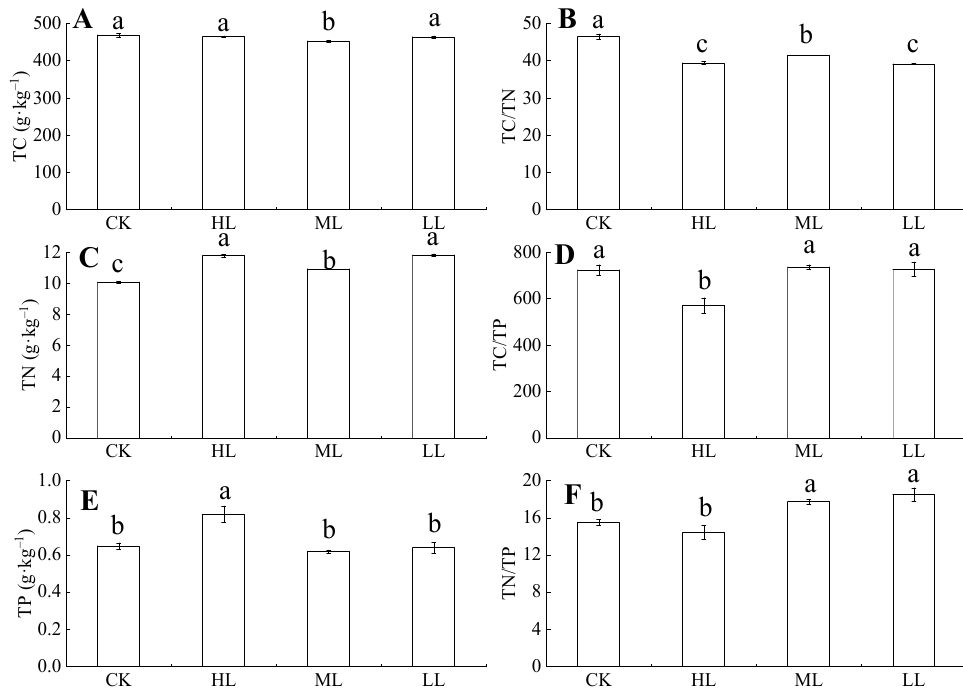
Figure 5. The TC, TN, TP contents and their ratios in C. oleifera leaves under different light regimes. Note: Parameters include TC ( A ), TC: TN ( B ), TN content ( C ), TC: TP ( D ), TP ( E ), and TC: TP ( F ) of C. oleifera under different light regimes. Different lowercase (a, b, c) letters represent significant differences between light regimes ( p < 0.05). Regime acronyms are defined as CK: 100% light regime; HL: 75% light regime; ML: 50% light regime; LL: 30% light regime.